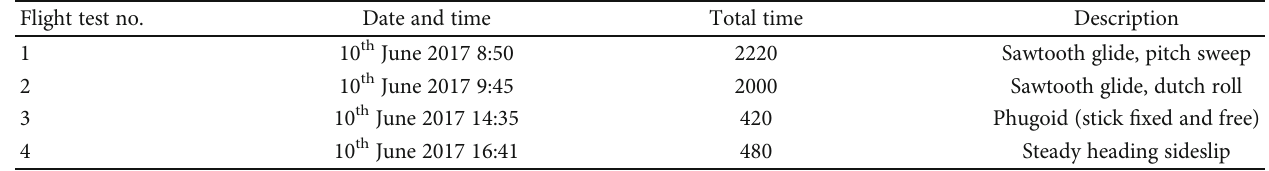
Steady heading sideslip